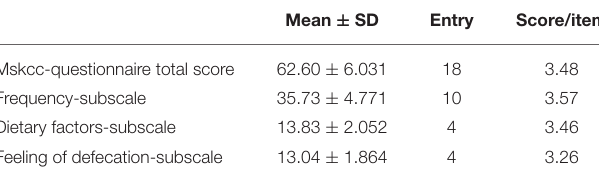
TABLE 2 | Scores of C-MSKCC and its three subscales.